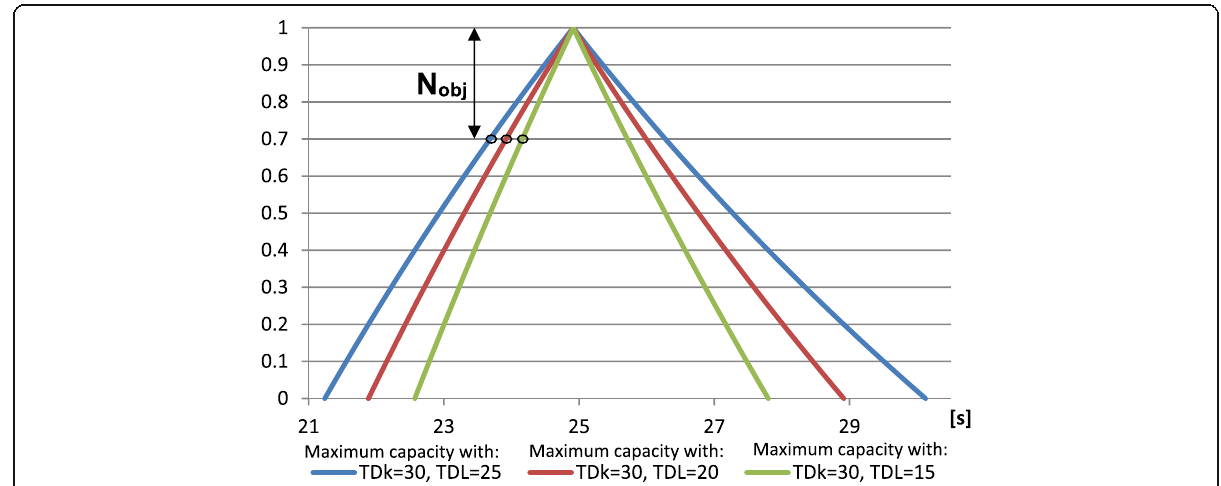
Fig. 14 Influence of T DL width variation on Fuzzy Maximum Capacity and C ope (Necessity = 0.3, Possibility = 1)